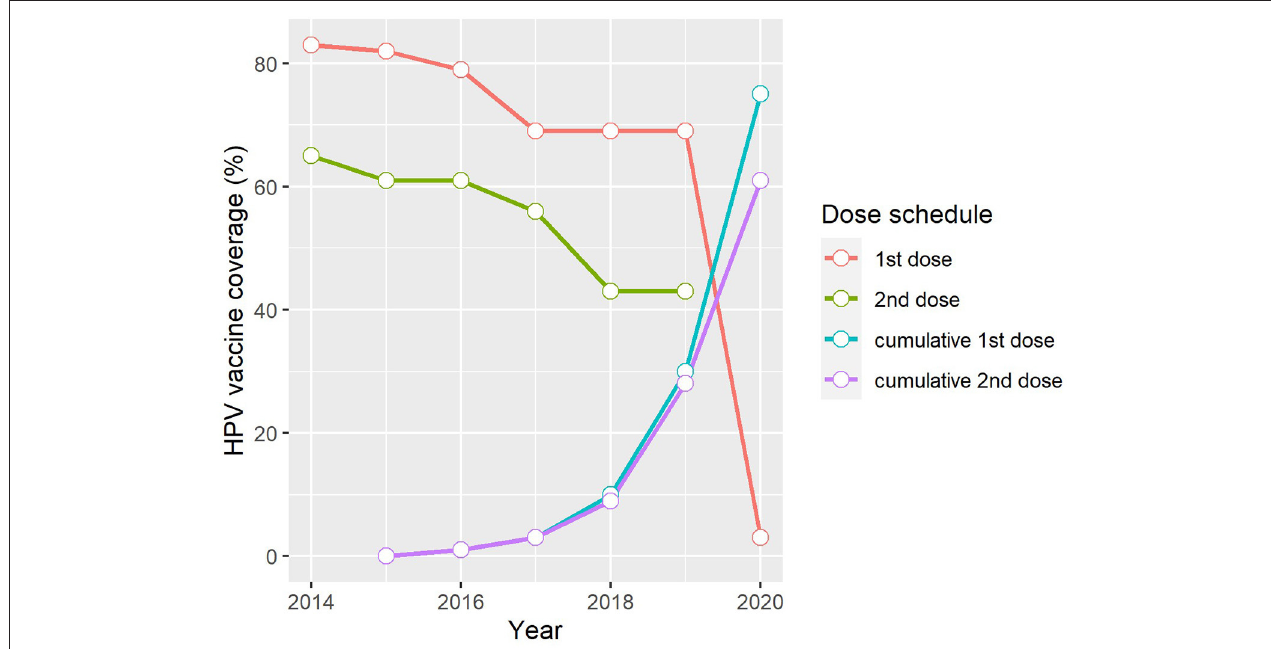
FIGURE 2 | Trends in HPV vaccine coverage in South Africa, 2014–2020 (17). 1st dose, Proportion of the target population who received the first dose of the HPV vaccine in the reporting year. 2nd dose, Proportion of the target population who received the last dose of the HPV vaccine in the reporting year. Cumulative 1st dose, Proportion of the population turning 15 years in the reporting year who received at least one dose of the HPV vaccine any time between ages 9–14 years. Cumulative 2nd dose, Proportion of the population turning 15 years in the reporting year who received the full recommended schedule of the HPV vaccine any time between ages 9–14